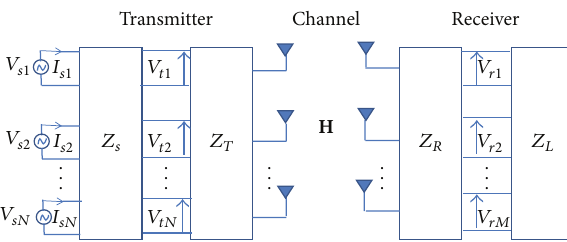
Figure 4: An 𝑀 𝑅 × 𝑁 𝑇 MIMO system based on mutual-coupling model.